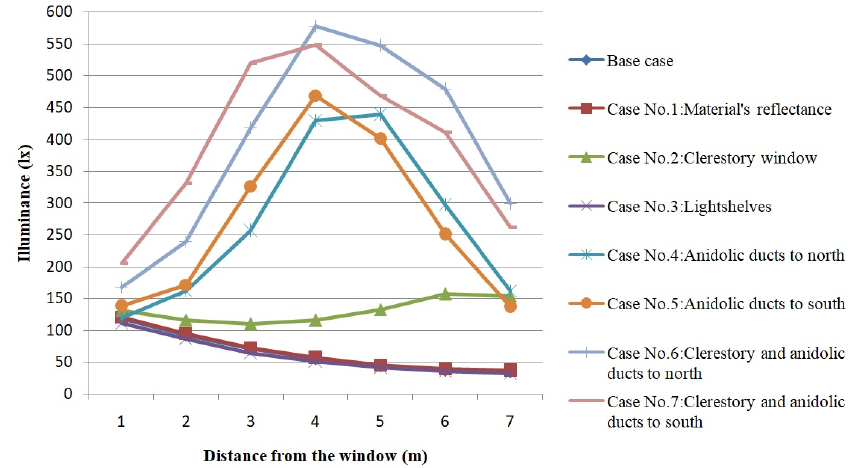
Buildings 2018 , 8 , x FOR PEER REVIEW 12 of 19 Figure 16. Comparison of average illuminance levels on the desks plane on 21 st of March at 12:00 pm. Figure 16. Comparison of average illuminance levels on the desks plane on 21 st of March at 12:00 Figure 16. Comparison of average illuminance levels on the desks plane on 21 st of March at 12:00 pm. pm.